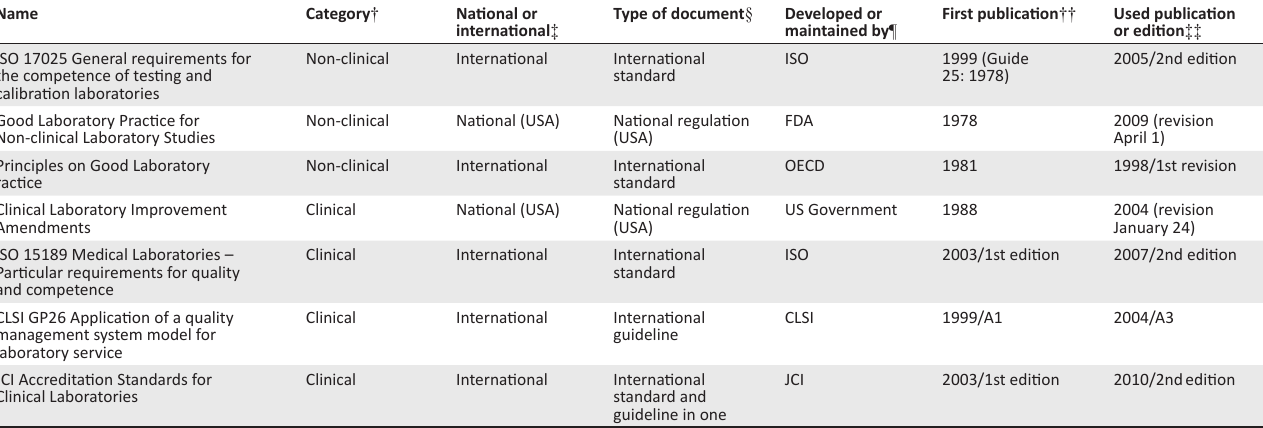
TABLE 1: Overview of analysed quality documents with their most important